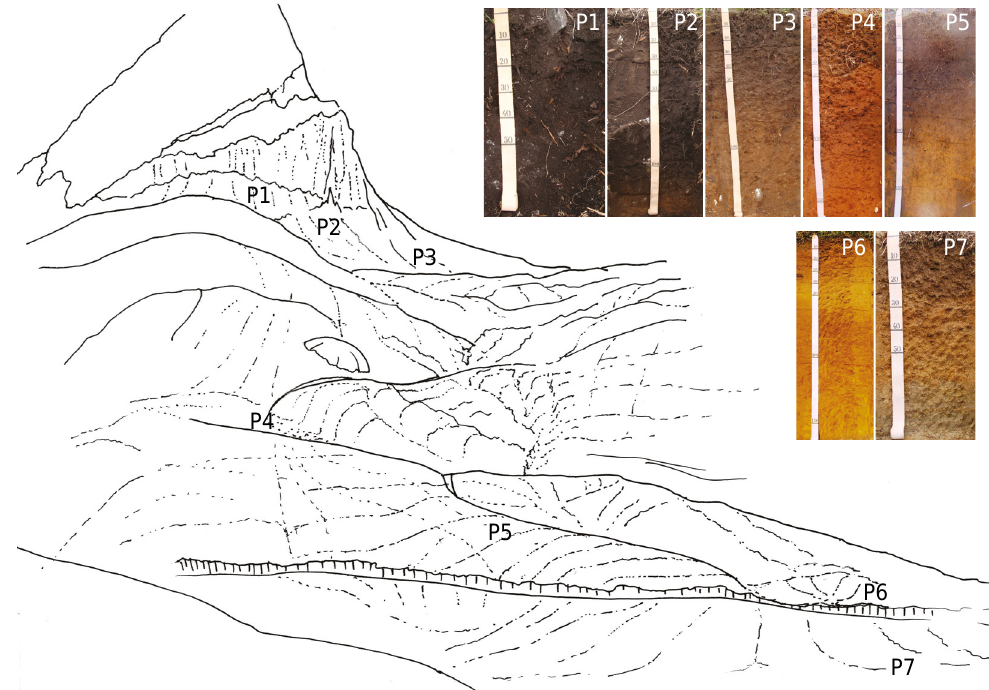
Figure 2. Schematic drawing of landscape and arrangement of soil profiles. Flow of the slope represented by dotted lines and landscape structure by solid lines. P1: Neossolo Litólico ; P2: Cambissolo Húmico; P3: Argissolo Vermelho-Amarelo ; P4: Argissolo Vermelho ; P5: Latossolo Amarelo ; P6: Argissolo Amarelo ; and P7: Neossolo Flúvico